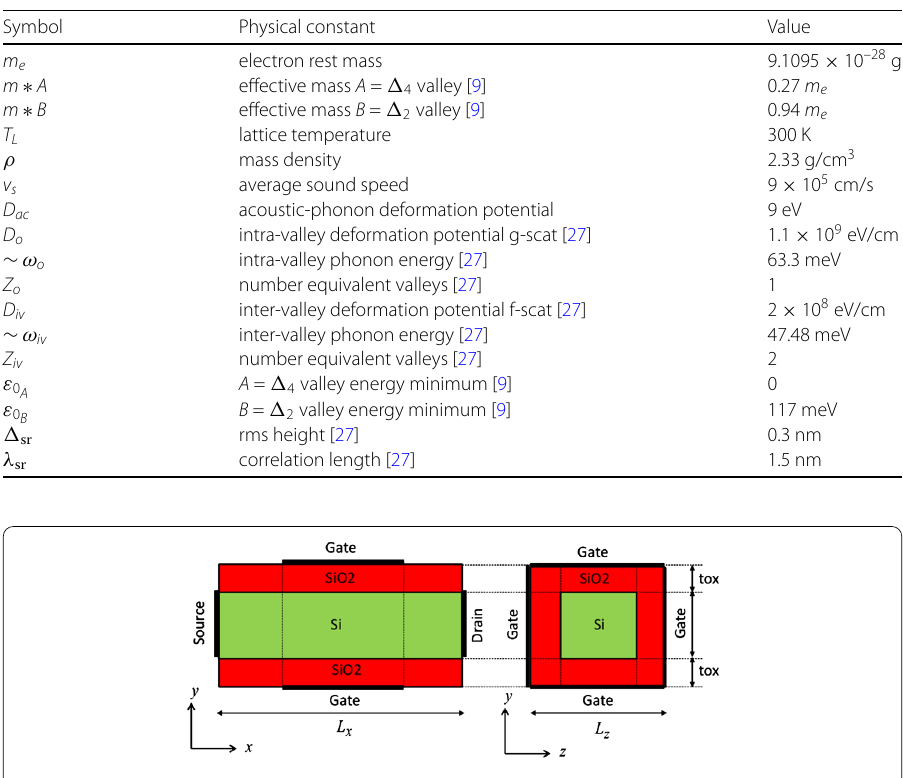
which gives rise to a deep potential barrier having U = 3.2 eV, and free to move in the or- thogonal x direction, having dimension L x (see Fig. 1). Hence, it is natural to assume the following ansatz for the electron wave function